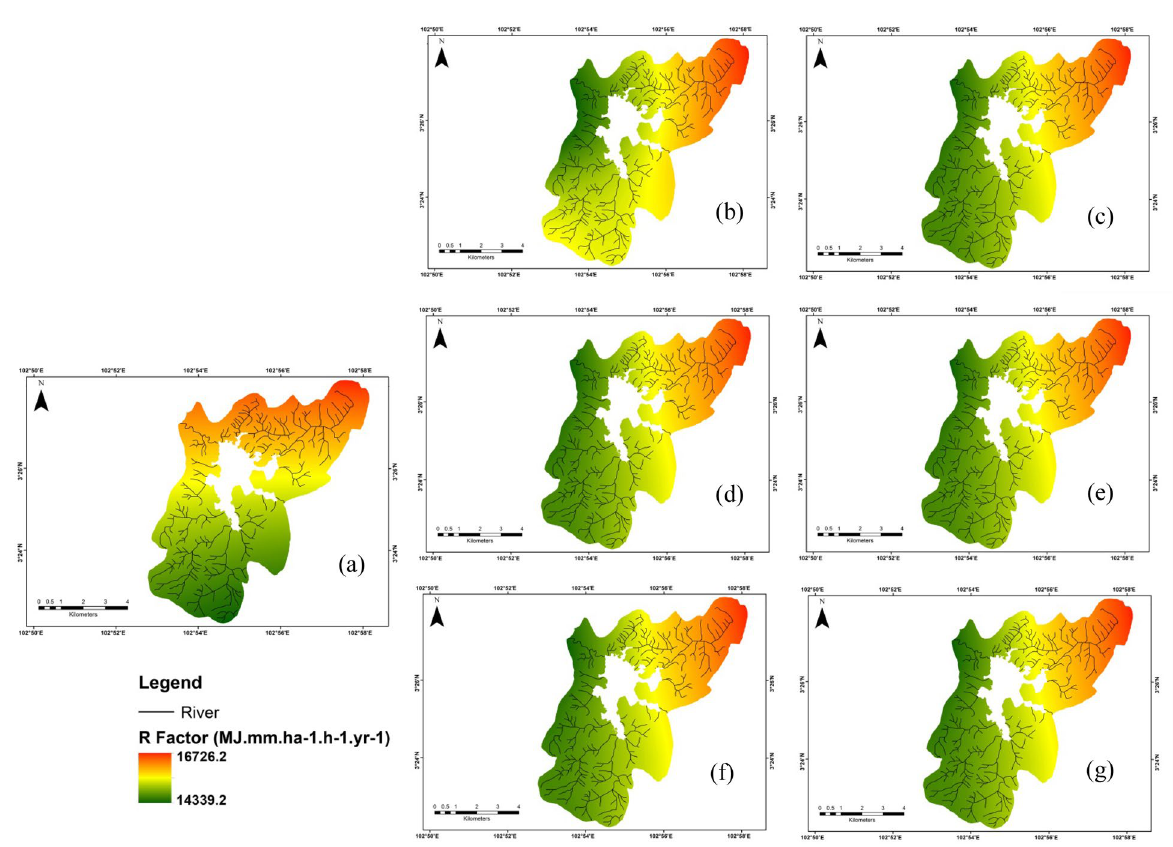
Fig. 7 Estimated changes in R factor according to the HadGEM3–GC31–LL model and SSPs for distinct scenarios ( a ) baseline 2019–2021, ( b ) SSP2.6 (2040–2060), ( c ) SSP2.6 (2060–2080), ( d ) SSP4.5 (2040–2060), ( e ) SSP4.5 (2060–2080), ( f ) SSP8.5 (2040–2060), ( g ) SSP8.5